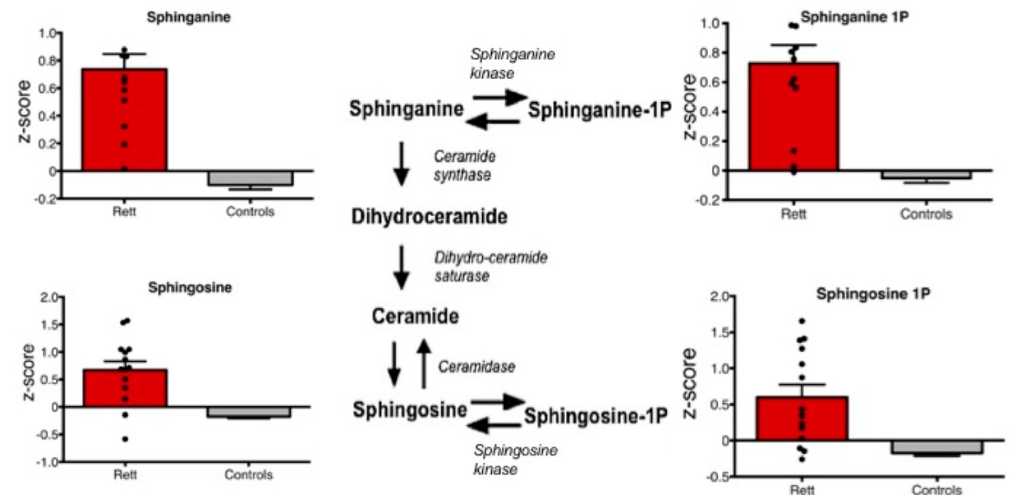
Figure 2. Box plots of plasma levels of specific sphingosine / sphinganine metabolites are shown. All shown metabolites are significantly increased in Rett syndrome cases compared to controls ( p < 0.01).